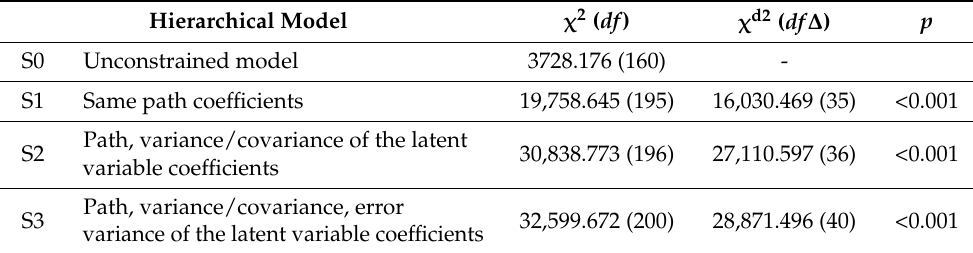
Table 4. Final Model’s Between-Group Homogeneity Test.